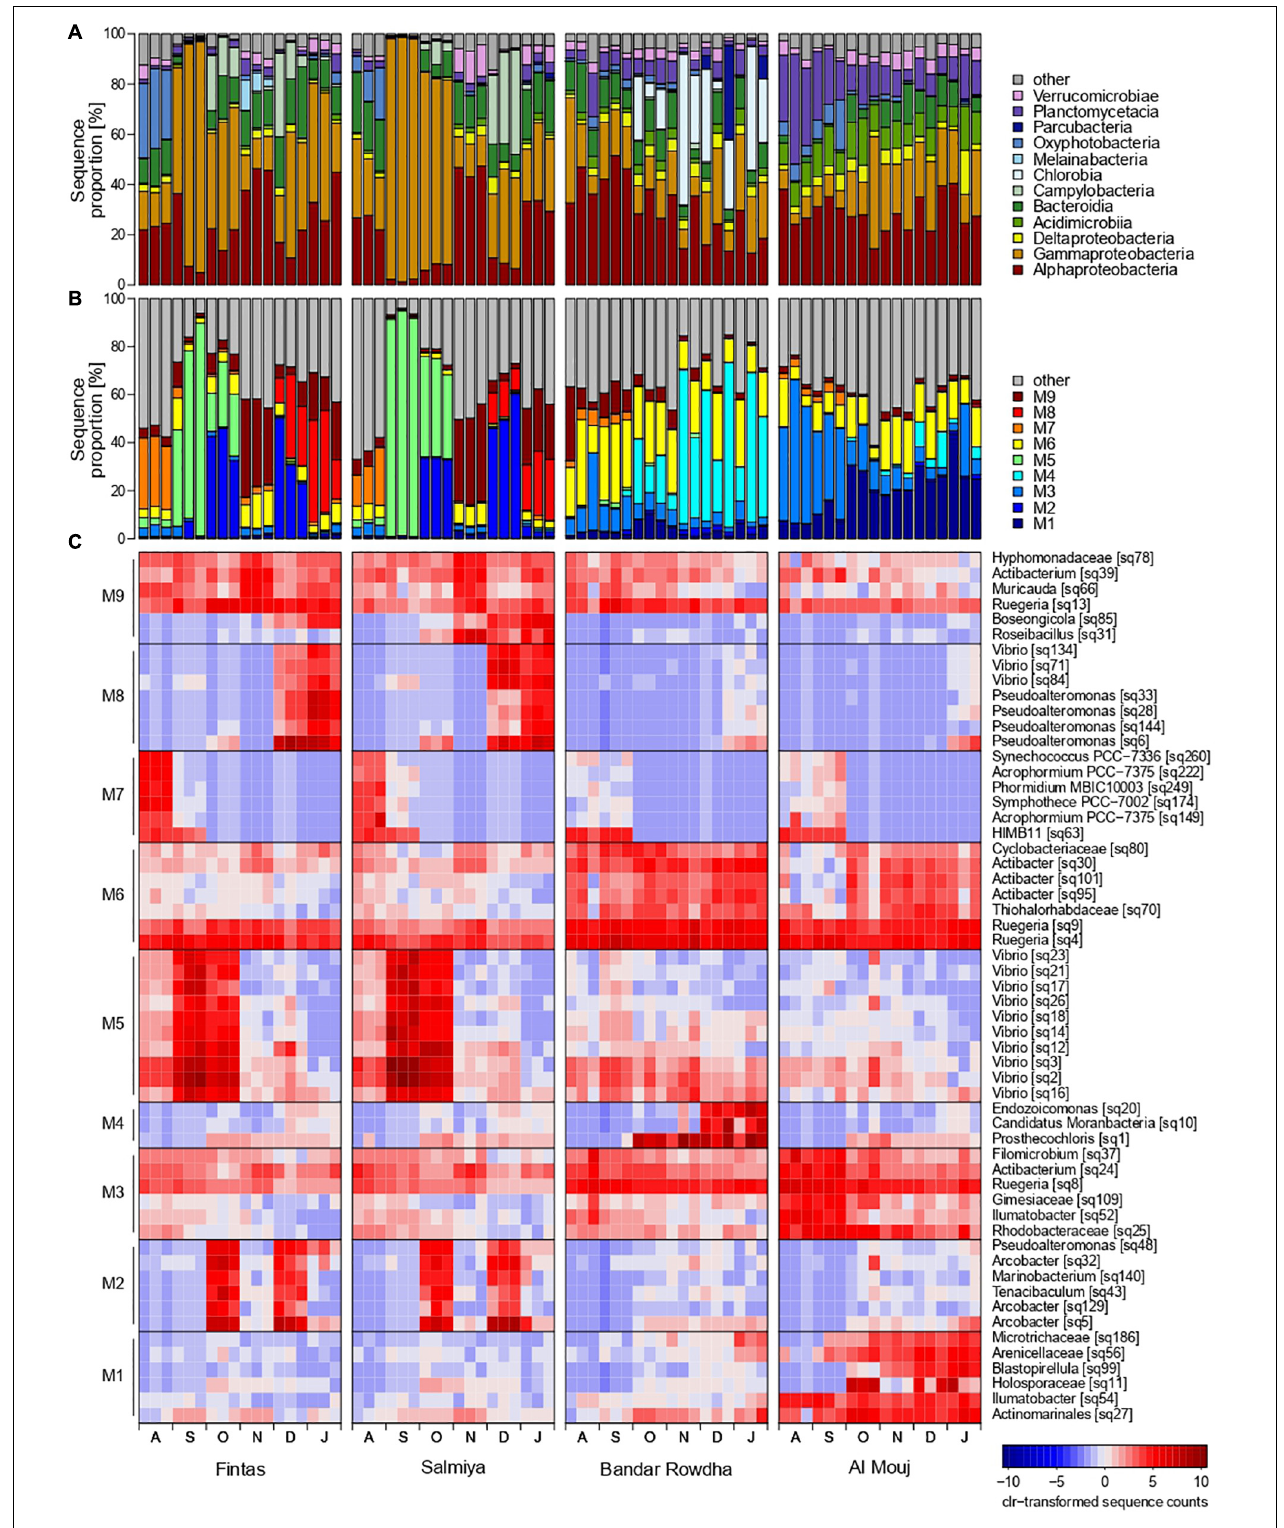
FIGURE 4 | Changes in the proportion of bacterial sequences affiliated to (A) dominant classes, (B) network modules, and (C) OTU representatives of each module at the sampling locations in Kuwait (Fintas and Salmiya) and Oman (Bandar Rowdha and Al Mouj) during the sampling period of 6 months from August 2017 to January 2018 (abbreviated as A, S, O, N, D,